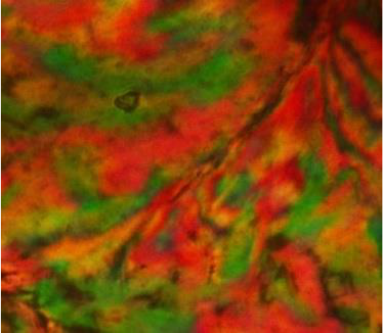
Figure 3. Optical texture of Cbz-H observed via polarized optical microscopy at 93 °C during the first heating process (scanning rate: 3.0 °C min − 1 ).